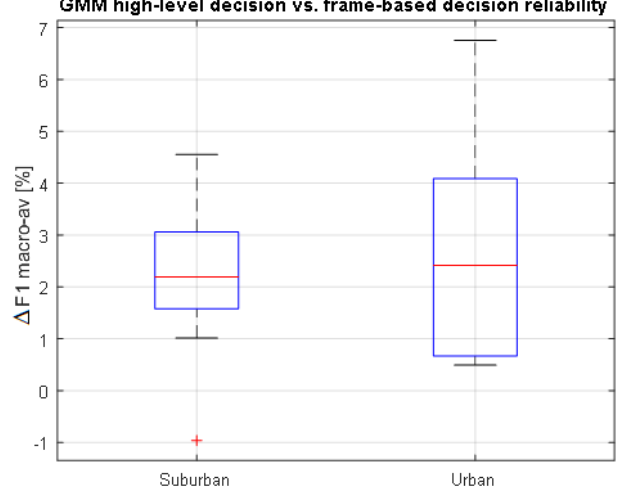
Figure 6. Boxplots of differences of the classifiers’ performance between high-level and frame-based decisions using the binary-based GMM classifier following a leave-one-out cross-validation scheme. Results are shown for suburban (left-side) and urban environments (right-side),